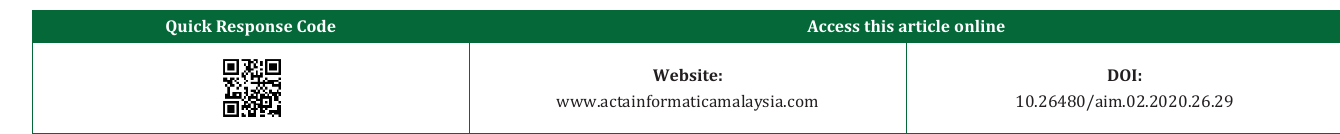
Figure 1: Schematic diagram of ACSI